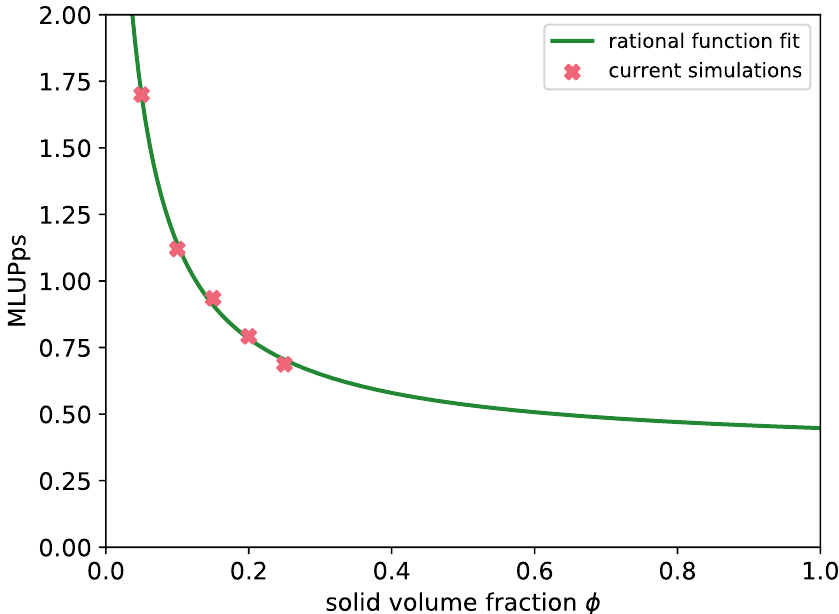
Figure 13. Performance data as million lattice updates per second and core, regarding the number of simulated particles.